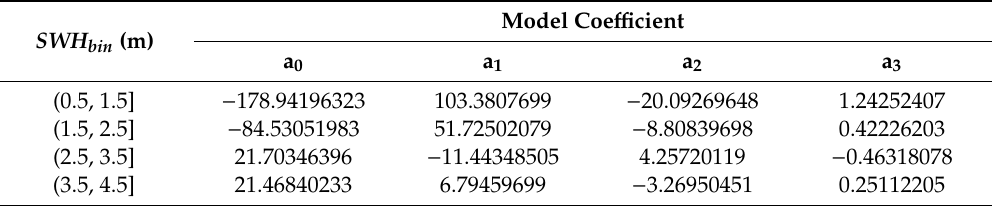
Figure 7. Parametric model details of ( a ) residual evolution with fitting degree, ( b ) fitting, and ( c ) error bars. For ( b ), the colours represent the different SWH bins. The dashed line represents the Interferometric Imaging Radar Altimeter (InIRA) sea surface height (SSH) mean bias (BIAS), while the solid line represents the fitting. Table 2. Parametric bias model coefficients for Interferometric Imaging Radar Altimeter (InIRA) sea surface height (SSH).